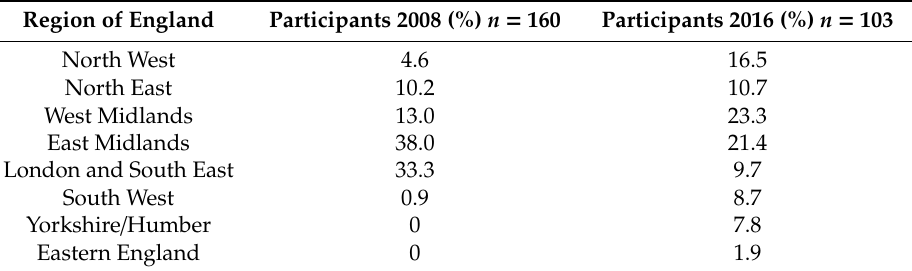
Table 1. Responses by